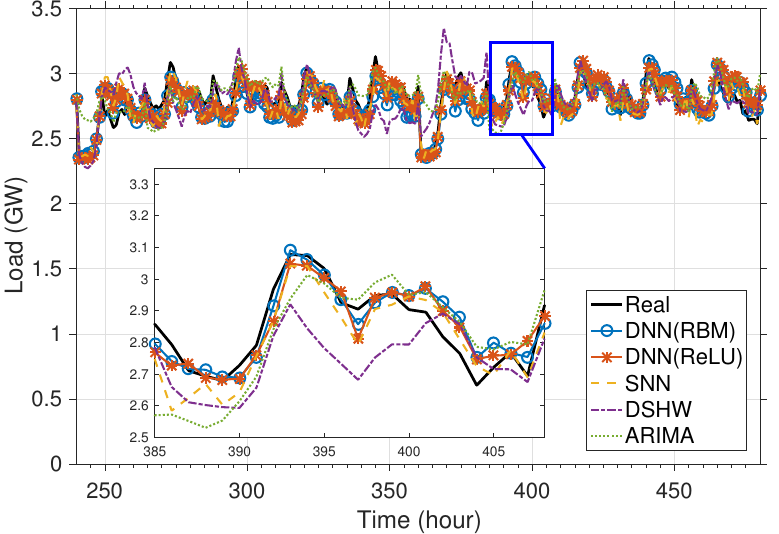
Figure 15. Predictions of the aggregated